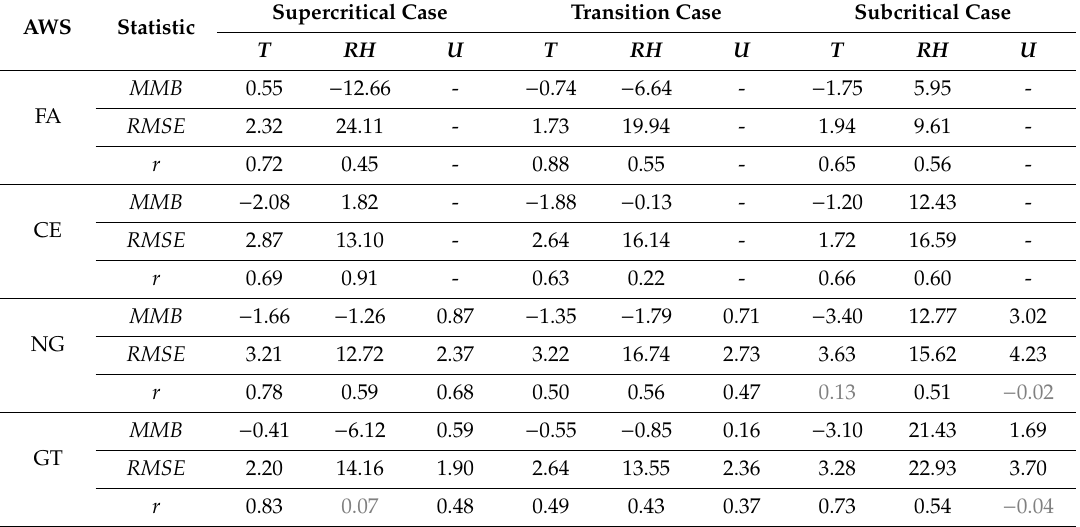
Table 4. Statistics of the model evaluation (mean model bias, MMB, root mean square error, RMSE, and Pearson correlation coe ffi cient, r ) at each AWS for the supercritical, transition and subcritical cases. Simulated wind speeds have been extrapolated from 10 to 2 m to be comparable with measurements. The MMB and RMSE are in the respective variable’s unit. Correlations that are not statistically significant ( p -value > 0.1) are greyed